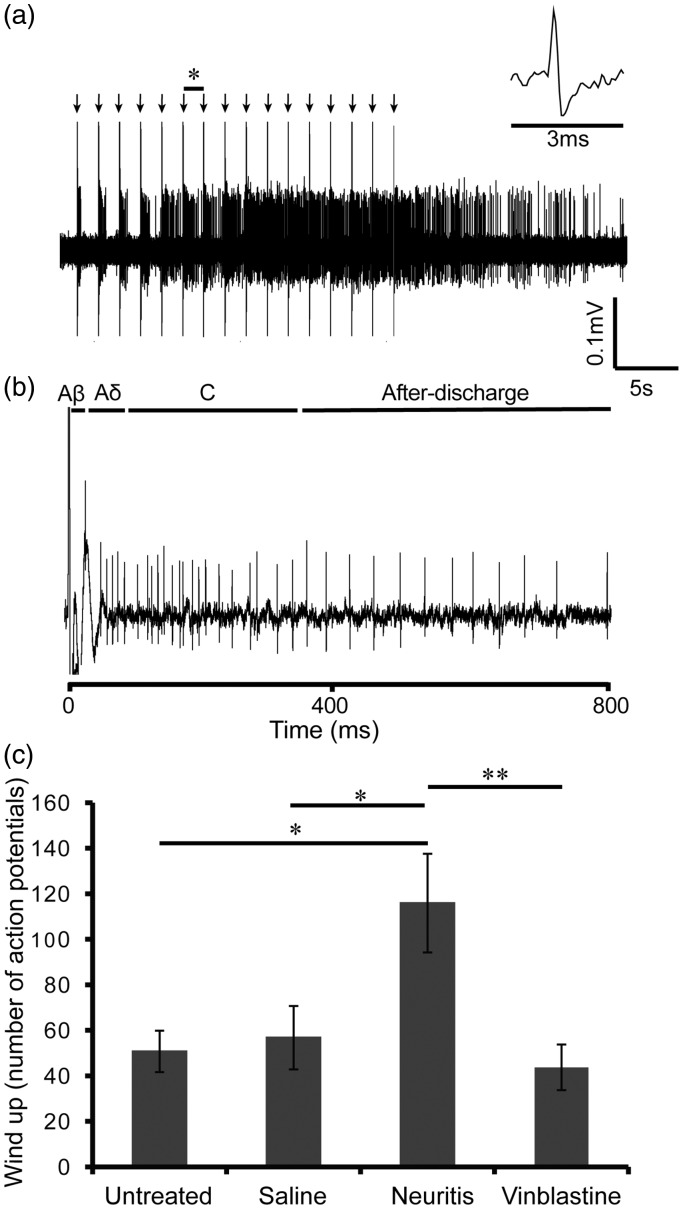
Wind-up responses. (a) Typical wind-up response from a neuritis animal. The center of the receptive field was electrically stimulated 16 times at 3× C-fiber threshold (arrows). (b) Expanded section of trace (* on part (a)), showing action potentials evoked by electrical stimulation. Action potentials were classified as Aβ-, Aδ-, or C-fiber–evoked based on the following latencies: Aβ, 0–20 ms; Aδ, 20–90 ms; C, 90–350 ms. Action potentials that occurred at a latency of 350–800 ms were considered post-discharge. (c) A comparison of the mean wind-up responses of WDR neurons in untreated, saline-treated, neuritis and vinblastine-treated groups. Wind-up was calculated as the sum of action potentials between 90 and 800 ms produced by 16 consecutive stimuli minus the input. n = 10, 11, 11 and 10 WDR neurons in the untreated, saline-treated, neuritis and vinblastine-treated groups, respectively. *p < 0.05, **p < 0.01 (one-way ANOVA followed by Bonferroni’s post hoc tests). Error bars = SEM.SEM: standard error of the mean.